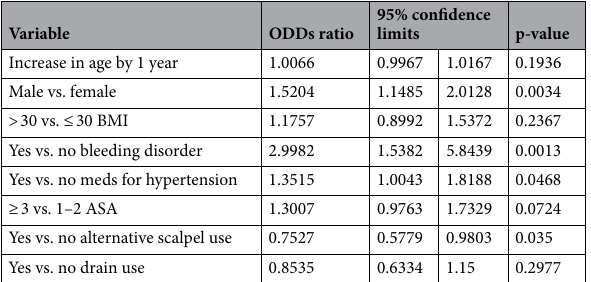
Table 4. Results of multivariate analysis for risk factors for post-operative hematoma.